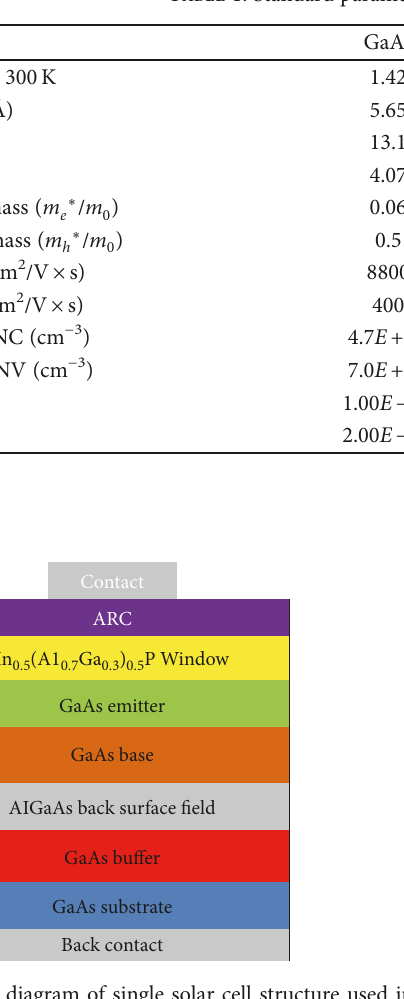
Figure 1: Schematic diagram of single solar cell structure used in the initial design.